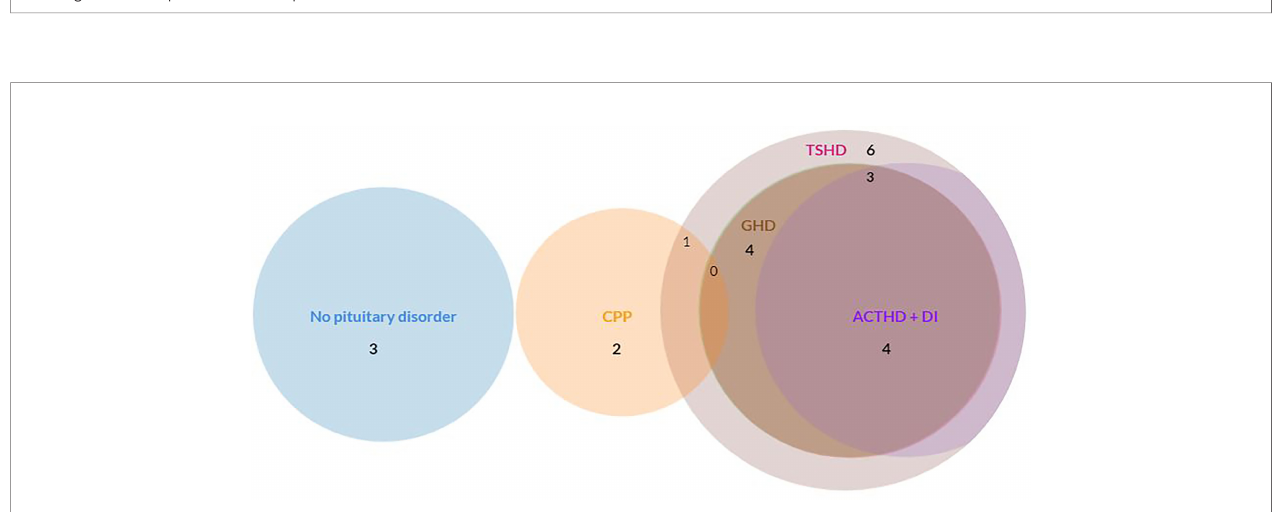
FIGURE 2 | Longitudinal BMI SDS over time. (A) Logistic regression (LOESS) plot of all patients. x-axis: age in years at moment of BMI follow-up, y-axis: BMI SDS corrected for age and gender. Orange beam shows 95% con fi dence interval. (B) Individualized BMI SDS data for each patient. This fi gure shows that the regression curve represents most of the patients, with only two outliers observed. Diencephalic syndrome de fi ned as BMI SDS < − 1.6 SD. Overweight de fi ned as BMI SDS >+1.6 SD. Legend shows patients in correspondence with Table 2